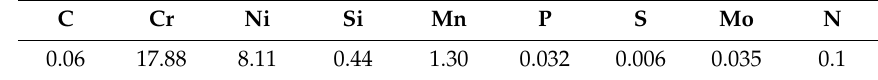
Table 1. Chemical composition of 304H stainless steel.